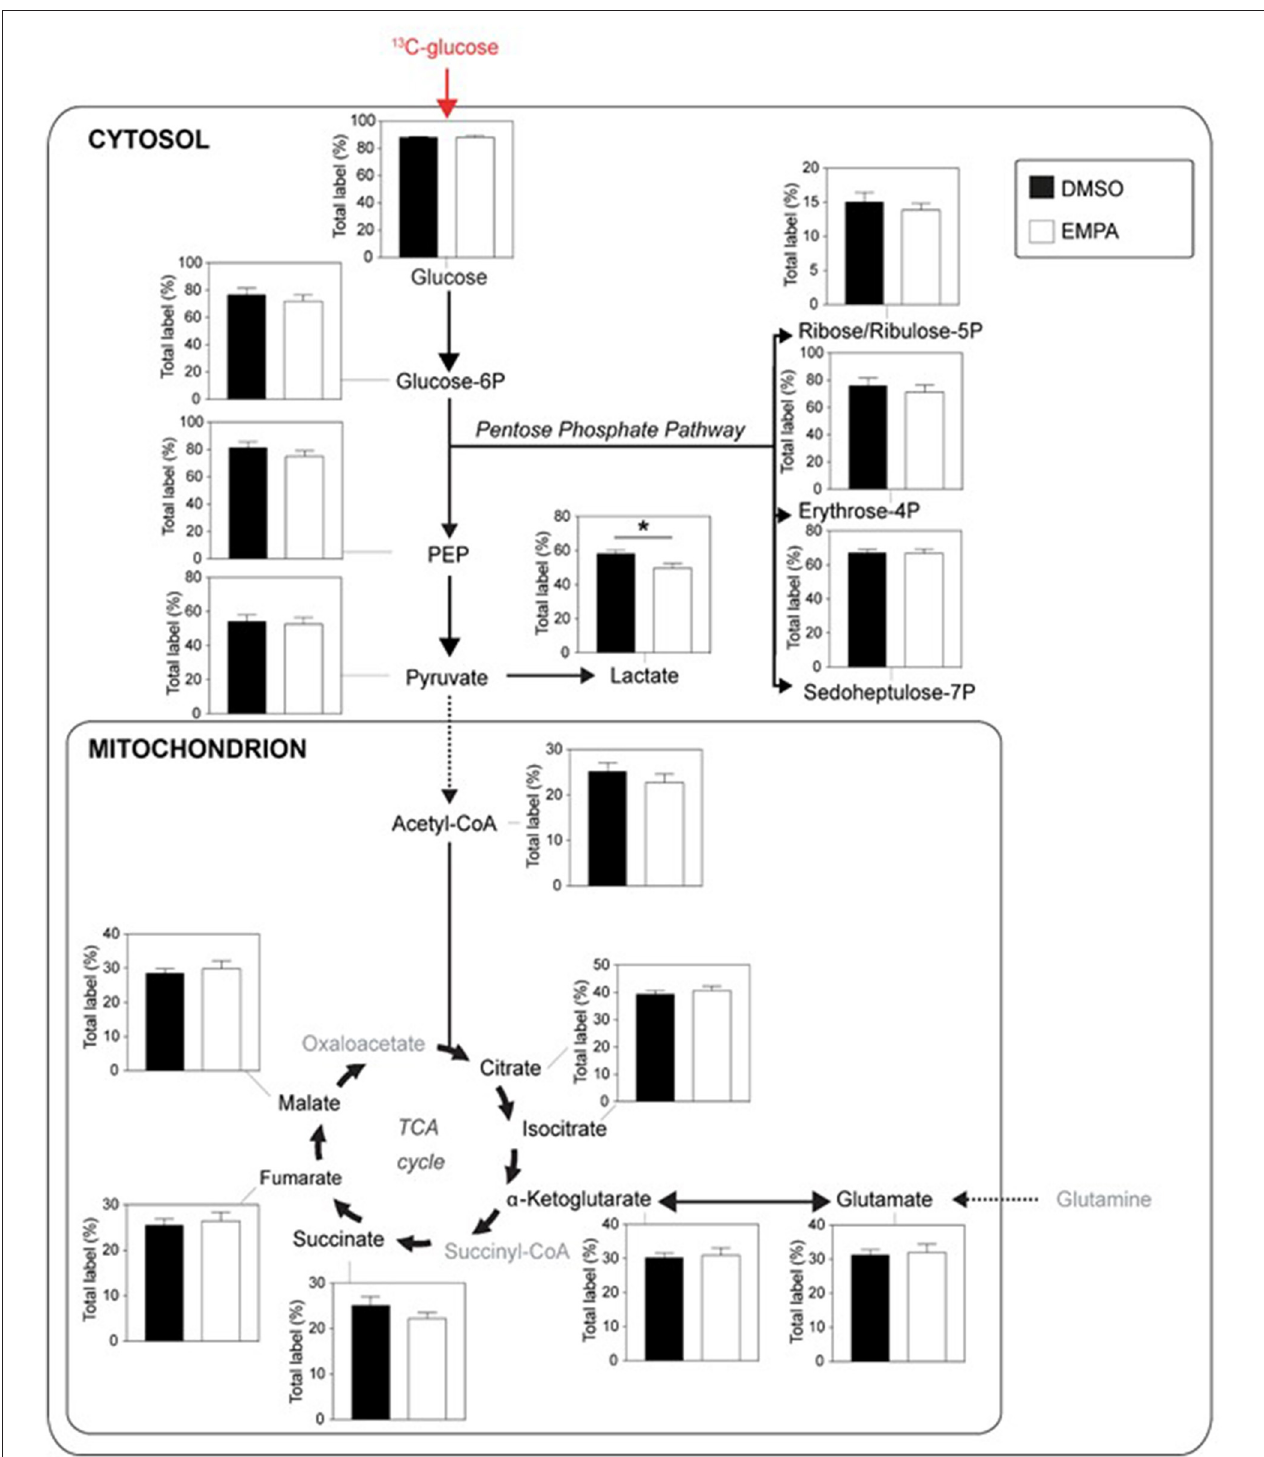
FIGURE 2 | EMPA’s direct effects on glucose metabolism of db/db hearts. EMPA’s effects on 13 C-labeling in metabolites of glycolysis, lactate generation, pentose phosphate pathway and TCA cycle when hearts were perfused with 5.5mM 13 C glucose; total label % = % metabolite labeled with 13 C; ppp = pentose phosphate pathway; DMSO ( n = 8), EMPA ( n = 8); * P < 0.05.